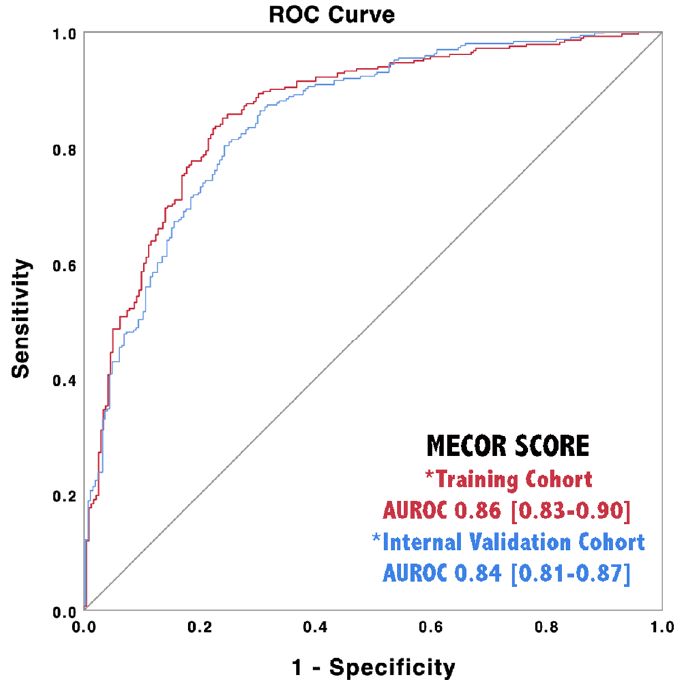
Figure 3. Discriminative ability of the MECOR Score in the training cohort (red line) and in the internal validation cohort (blue line).